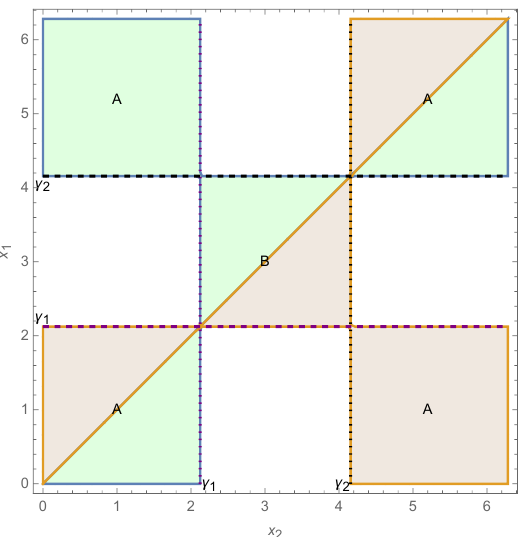
Figure 5 . Plot showing the allowed regions in x 1 and x 2 . The green regions indicate the allowed ranges for η while the brown regions indicate that for ¯ η . γ 1 and γ 2 label the fixed points of the flow (These are the same points that are labelled as x fp ± on the circle in figures 1, 3 and 4). All distances are scaled in units of L 2 π